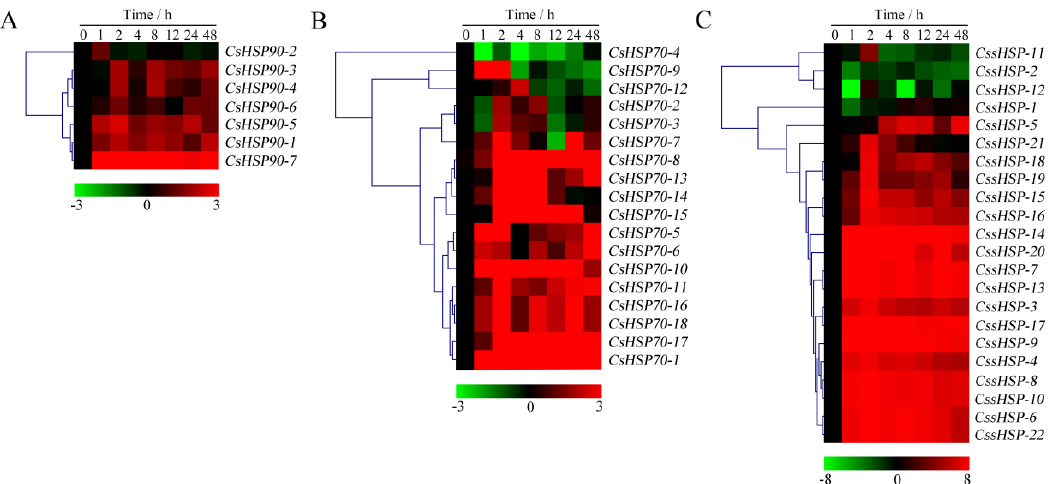
Figure 7. Expression profiles of CsHSP90 ( A ), CsHSP70 ( B ), and CssHSP ( C ) genes in tea plant under heat stress (40 °C). The heatmap was generated by MeV software using the CsHSP genes expression data, and normalized log 2 transformed values were used with hierarchical clustering. The red and green colors indicate higher or lower transcript abundances than those of the relevant control, respectively.